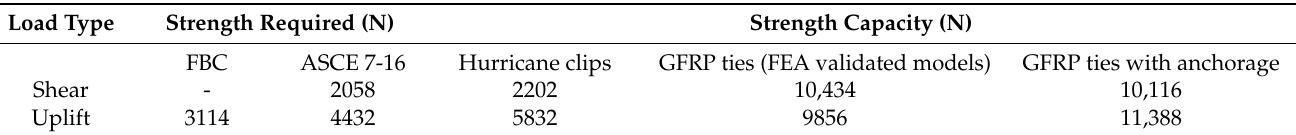
Table 6. Comparison of shear and uplift loads for different connections.